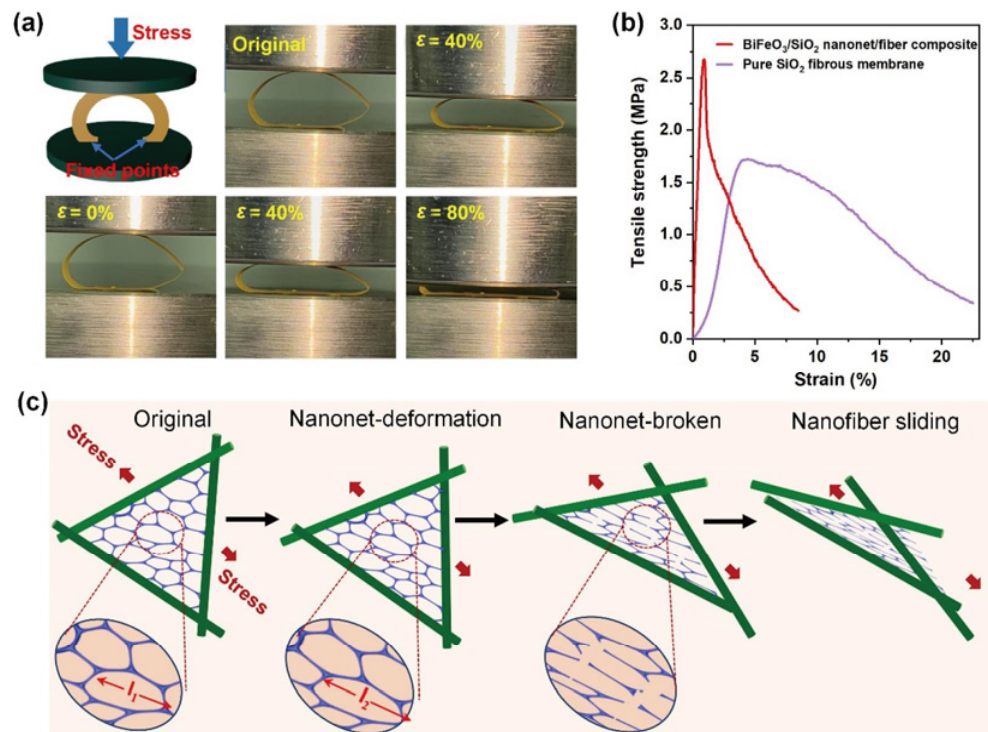
Fig. 3 Mechanical properties of BiFeO 3 /SiO 2 nanonet/fiber composite membrane. (a) Schematic and optical photographs during the compress–release process of BiFeO 3 /SiO 2 nanonet/fiber composite membrane. (b) Tensile stress–strain curves of BiFeO 3 /SiO 2 nanonet/fiber composite membrane and pure SiO 2 nanofibrous membrane. (c) Schematic description of the changes of the nanonet/nanofiber structure under continuous tensile